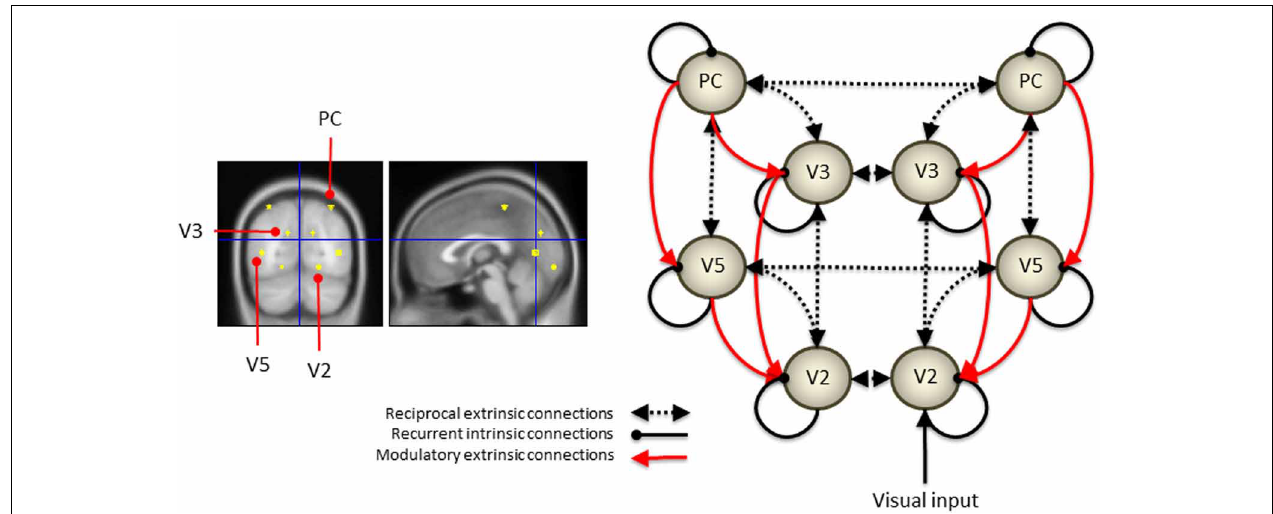
FIGURE 3 | The location of the eight sources is shown in the panels on the left. To construct the DCM, these sources were connected in the distributed network shown on the right. The parietal sources sent both driving and modulatory backward